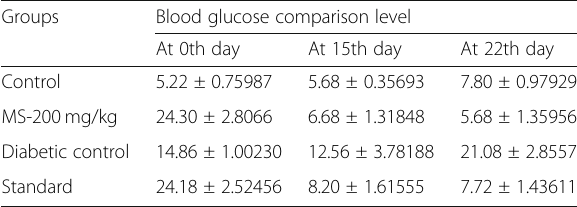
Table 2 Effects of EMSL on blood glucose level in alloxan induced diabetic nephropathy mice